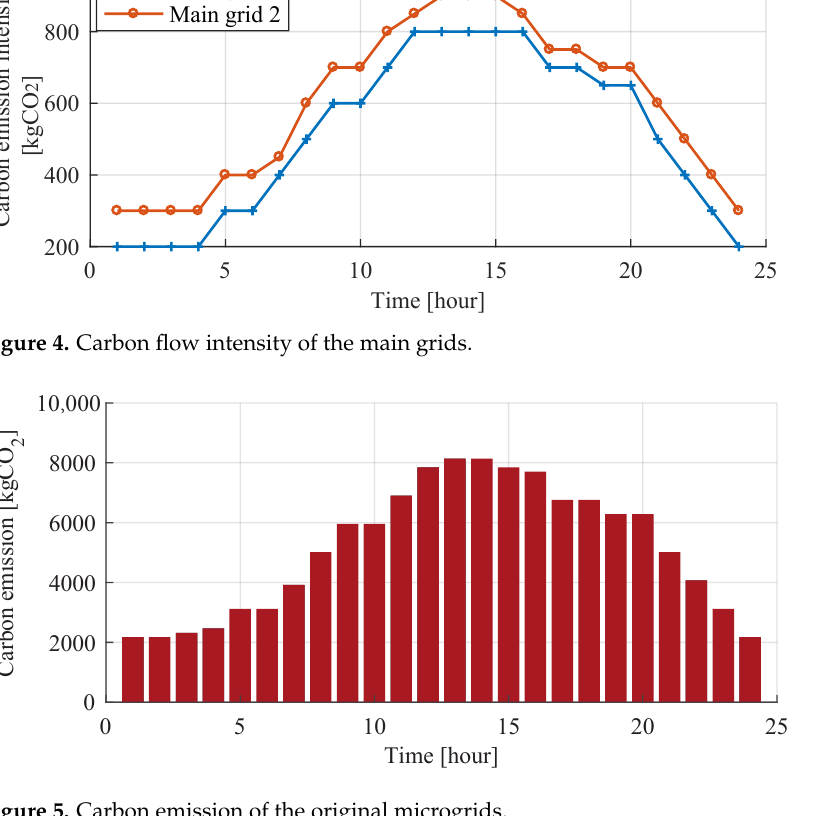
Figure 5. Carbon emission of the original